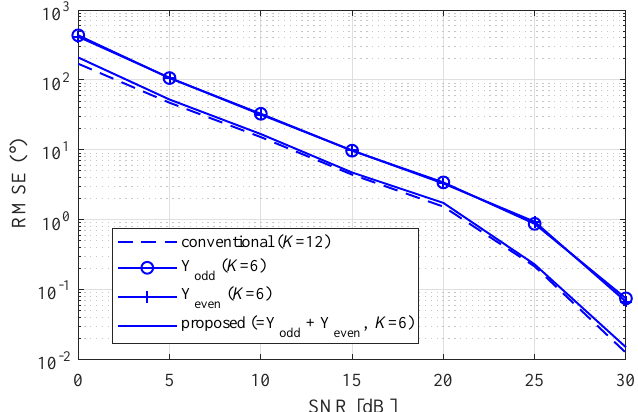
Figure 10. Root-mean-square error (RMSE) according to SNR with K = 12 and